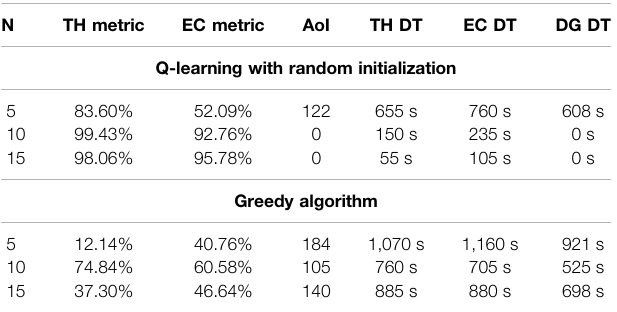
TABLE 3 | Comparative analysis results obtained for an operative scenario made up of 2 UAVs which are expected to serve 5 – 10-15 users. Q-learning random initialization refers to the usage of Q-learning algorithm by randomly initializing the values of the Q-table, while the greedy algorithm is the comparative baseline we used to evaluate UAVs